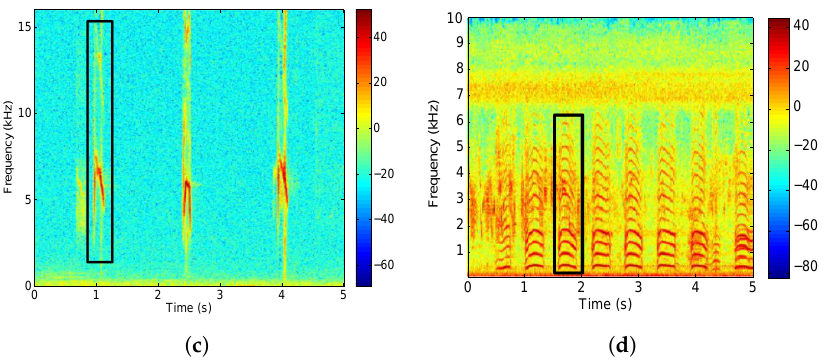
Figure 4. Spectrograms for several birdsongs where call examples have been highlighted. ( a ) Botaurus stellaris ; ( b ) Ciconia ciconia ; ( c ) Motacilla flava ; and ( d ) Porphyrio porphyrio .